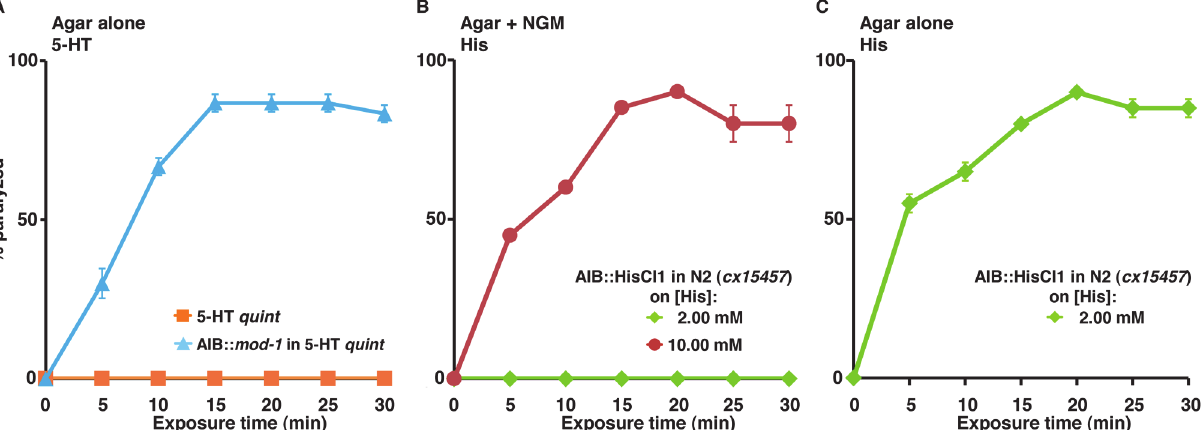
Fig 6. Inhibiting signaling from the two AIB interneurons causes “ locomotory confusion ” and paralysis. A-C. Paralysis of wild type, mutant and transgenic C . elegans on either NGM or non-NGM agar plates. A. 5-HT quint and 5-HT quint animals expressing MOD-1 in the AIBs (P inx-1 ) were examined for 5-HT (1 mM)-dependent paralysis on non-NGM agar plates, as outlined in Methods. Data are presented as mean ± SE (n = 3). B and C. Wild type animals expressing HisCl1 in the AIBs ( cx15457 ) were examined for histamine (2 or 10 mM)-dependent paralysis on NGM ( B ) and non-NGM ( C ) agar plates. Data are presented as mean ± SE (n =